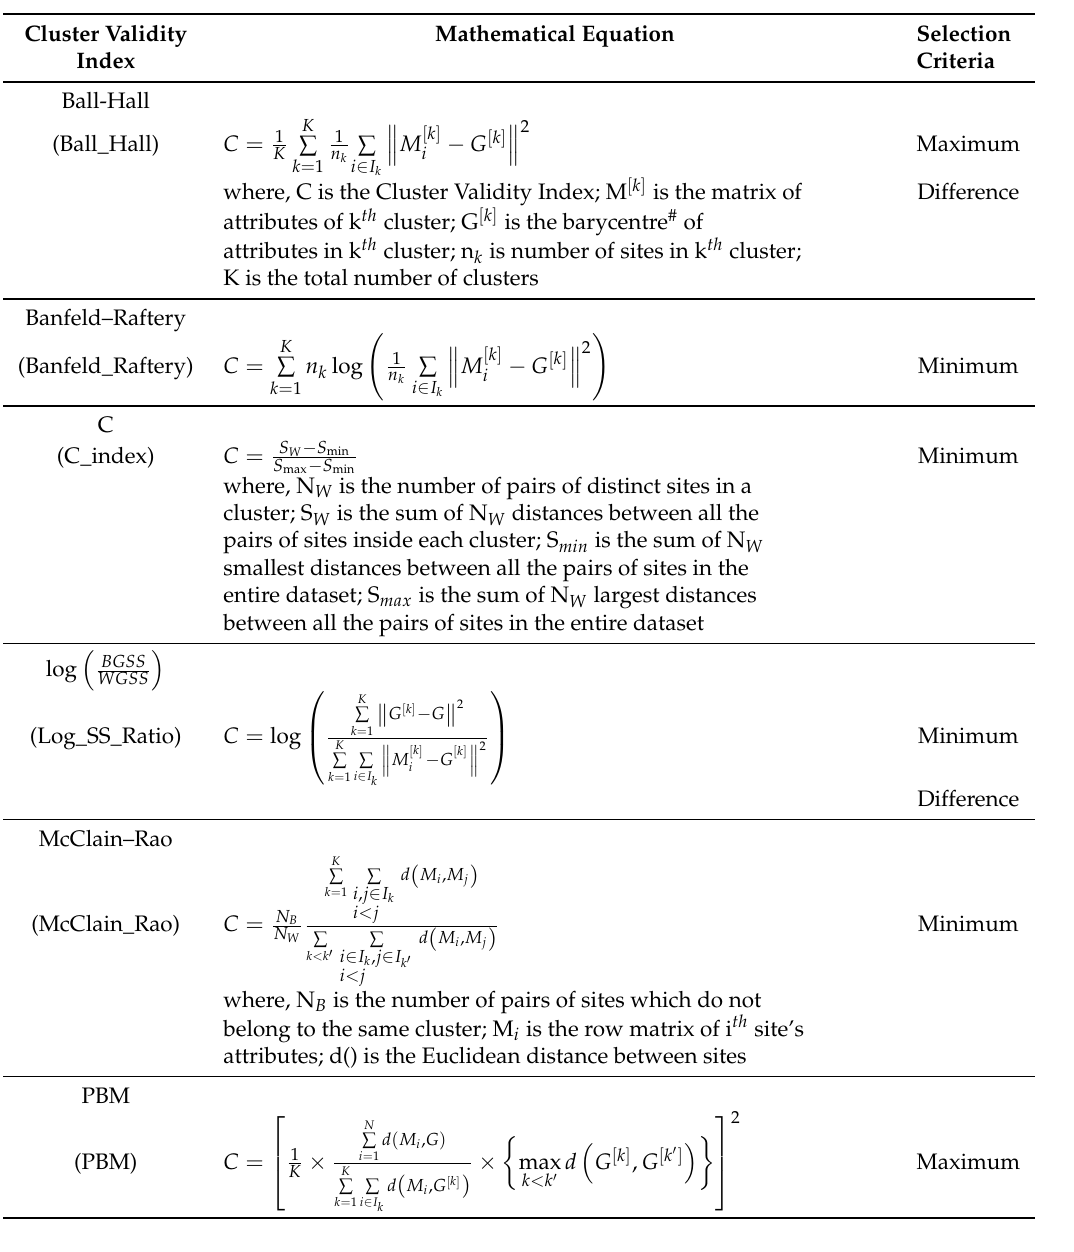
Table A1. Cluster validity indices from clusterCrit R package developed by Desgraupes [50]. The clusterCrit name for each cluster index is presented in parenthesis. If the selection criteria is, minimum difference or maximum difference then, the clusters corresponding to the index value at which there is minimum slope or maximum slope difference versus number of clusters curve should be